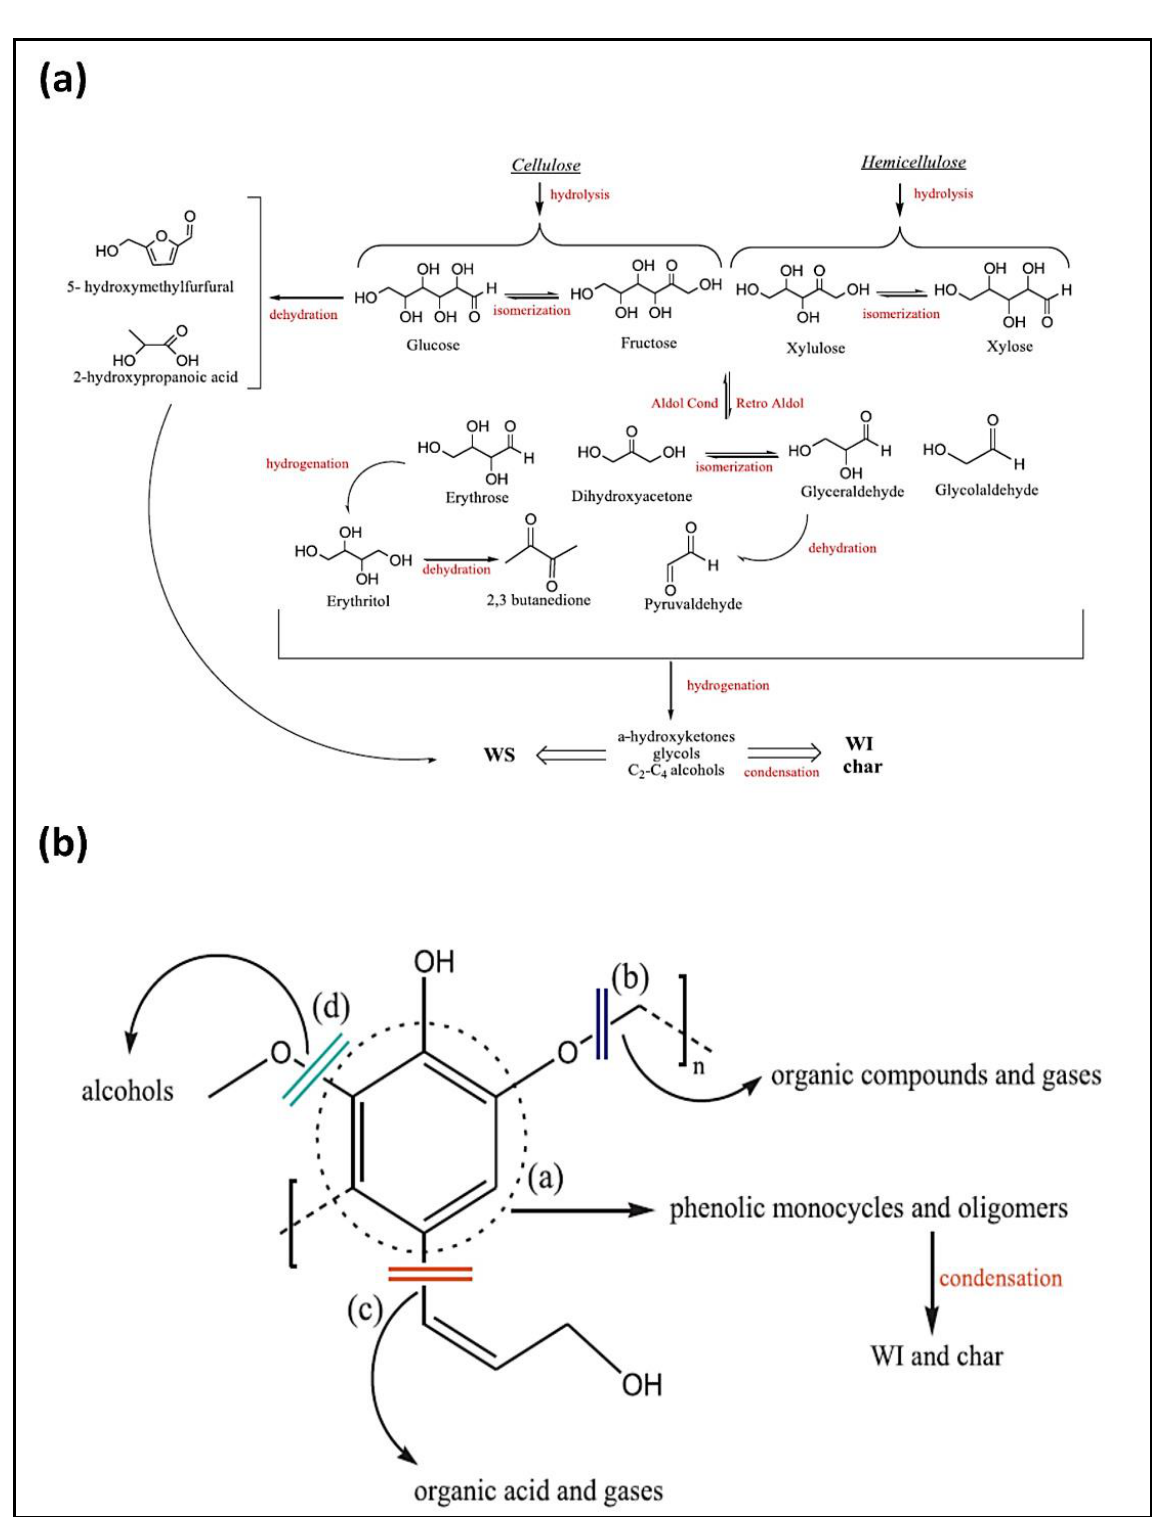
Figure 5. Decomposition of, ( a ) cellulose and hemicellulose, ( b ) lignin, adapted from [33].